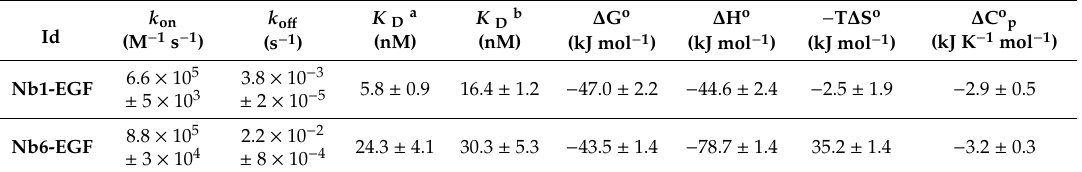
Table 1. Summary of all kinetic and thermodynamic constants.